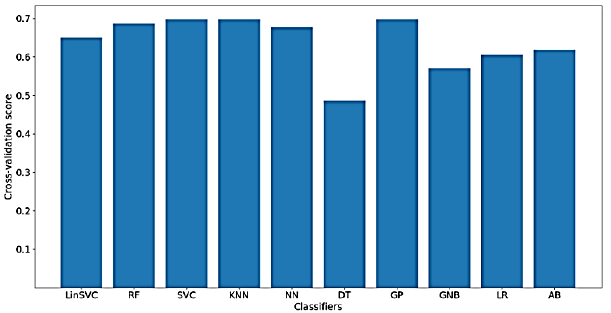
Figure 12. Performance of implemented classifiers for the classification of FA scores using raw data and only time-domain features.